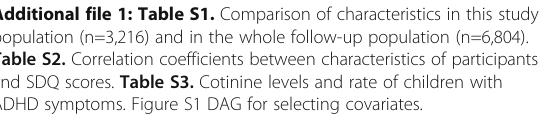
Table S2. Correlation coefficients between characteristics of participants and SDQ scores. Table S3. Cotinine levels and rate of children with ADHD symptoms. Figure S1 DAG for selecting